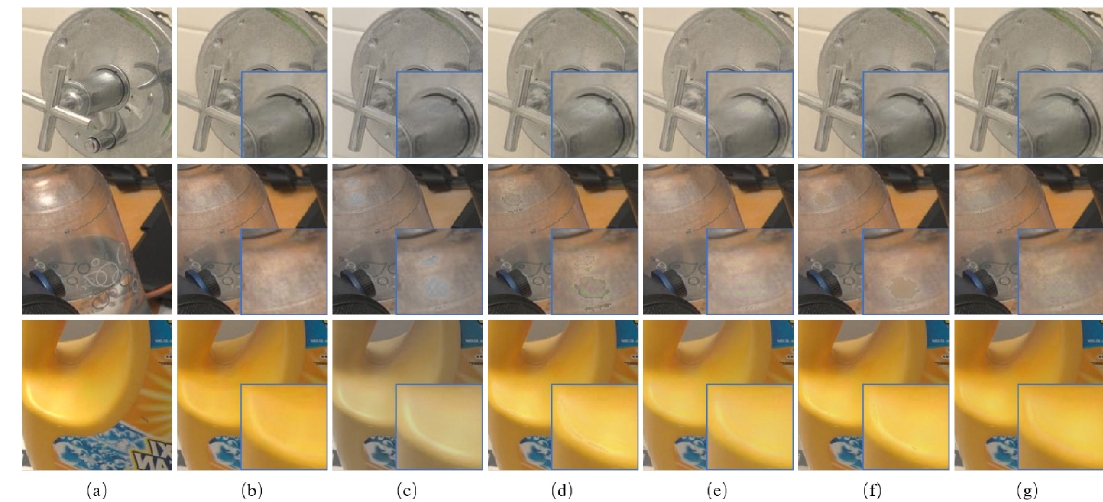
Fig. 7 Visual examples from ablation studies for the proposed network: (a) input, (b) ground-truth, and results from (c) our method without Swin transformer, (d) our method without highlight mask, (e) our method without pixel loss, (f) our method without style loss, and (g) our overall method.